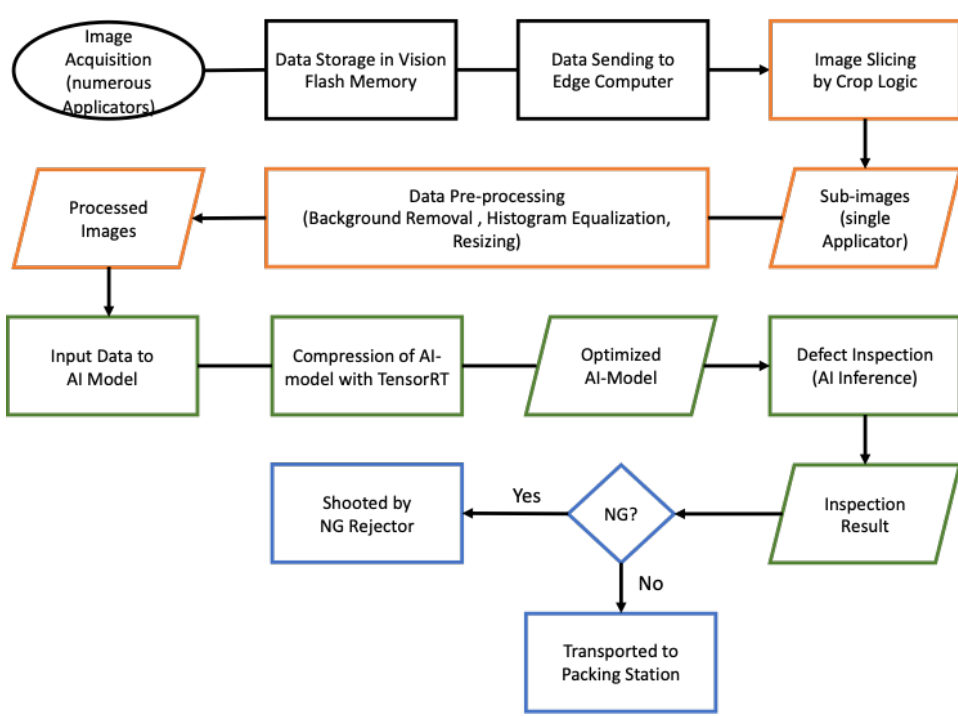
Figure 10. Inspection algorithm of the proposed system.